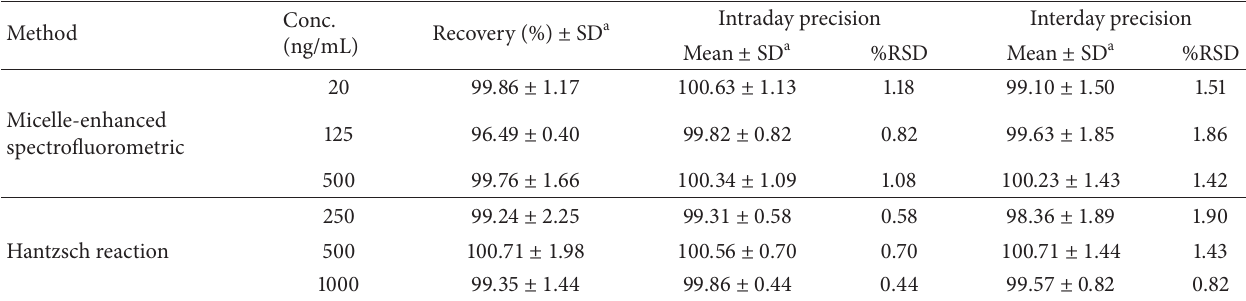
Table 2: Intraday and interday precision of the proposed